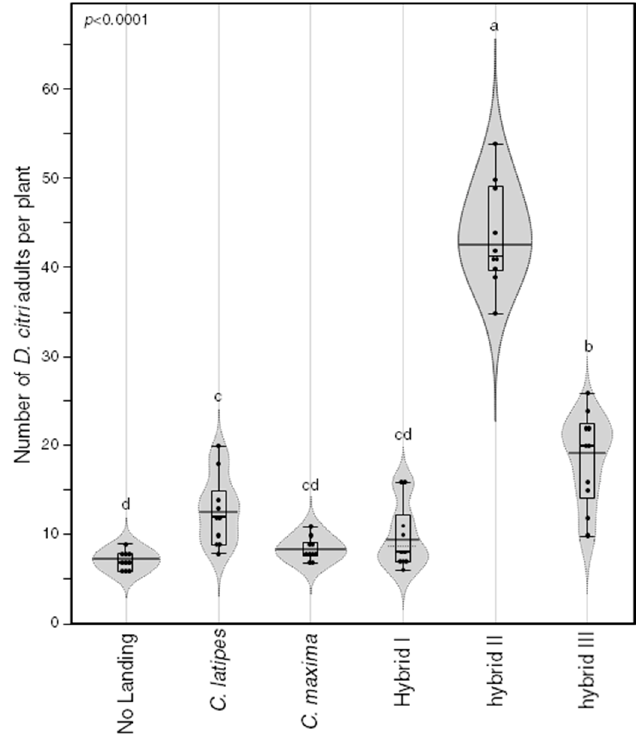
Figure 6. Settling preference of D. citri on C. maxima , Citrus latipes and their corresponding sexual hybrids (Hybrid I, Hybrid II and Hybrid III). Horizontal thick black and gray lines indicate the medians and means ( n = 10 ), respectively. Black dots represent individual data points. Boxes show the interquartile ranges including 25–75% of the values, whiskers reflect the highest and the lowest value of data. Gray violin polygons represent the estimated density of the data. Di ff erent letters indicate statistically significant di ff erences among treatments using the Tukey–Kramer honest significant di ff erence test (Tukey HSD; p < 0.05).